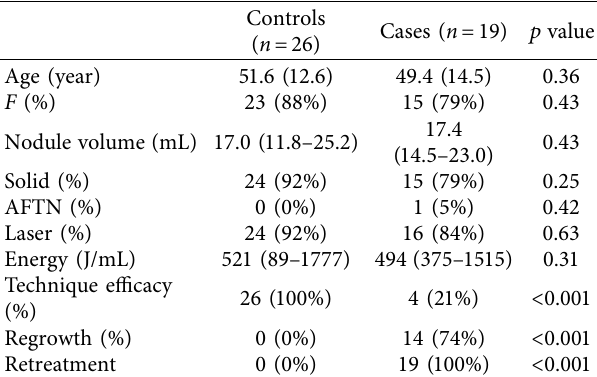
Table 1: Patient characteristics.